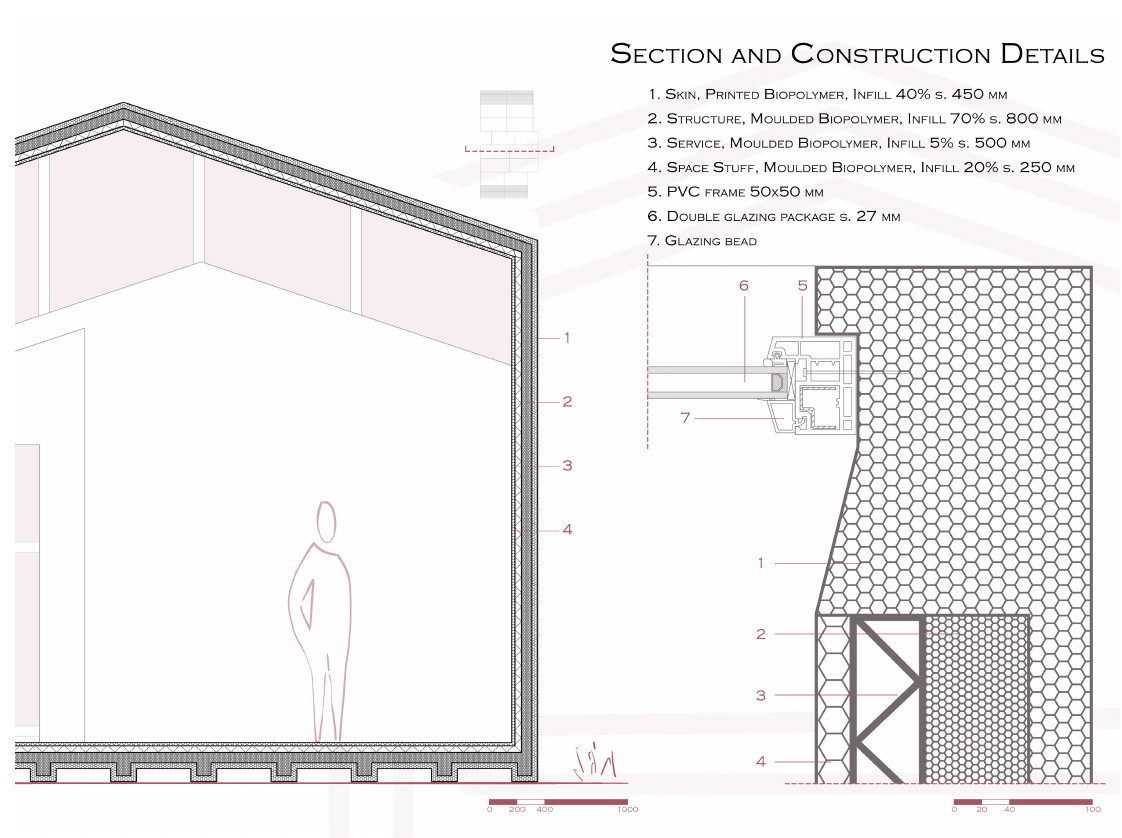
Figure 4. Cross-section and Detail of